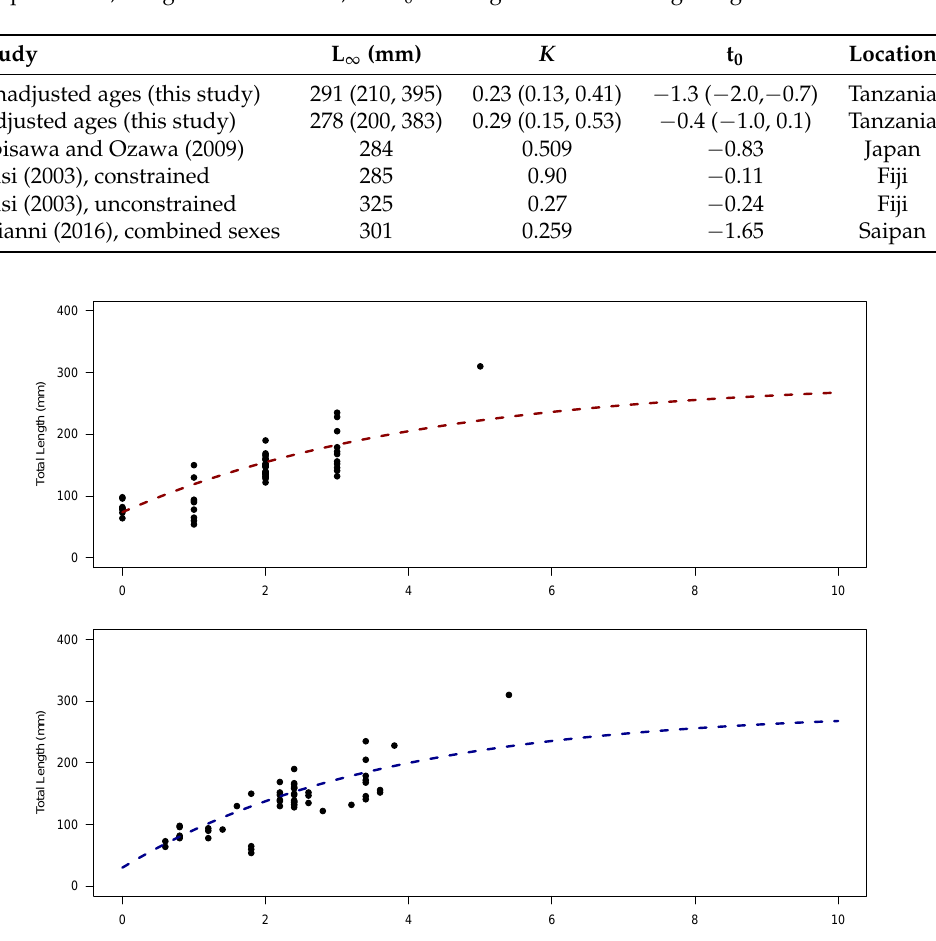
Table 2. Von Bertalanffy parameter estimates from this study and other studies of L. harak . Estimates of uncertainty for this study are 95% credible intervals in parentheses. Other studies did not evaluate uncertainty. See Lasi [7] for details on the constrained and unconstrained models. L ∞ = maximum